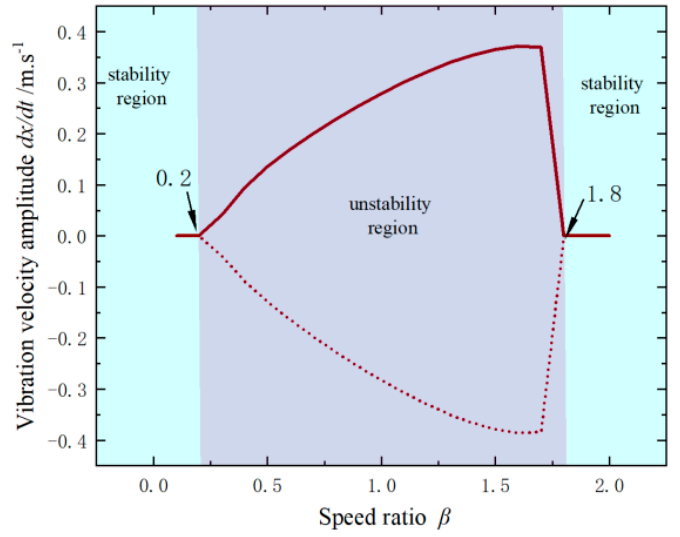
Figure 5. Bifurcation diagram of the system with the variation in β .